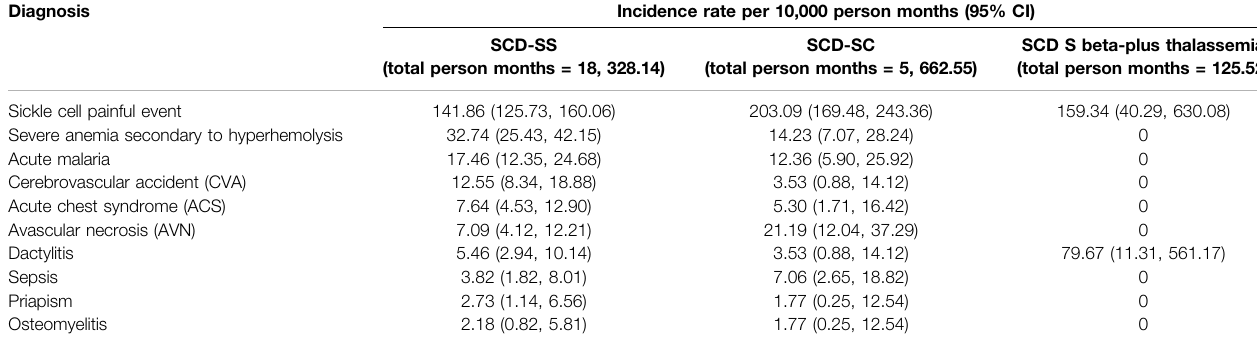
TABLE 3 | SCD-related